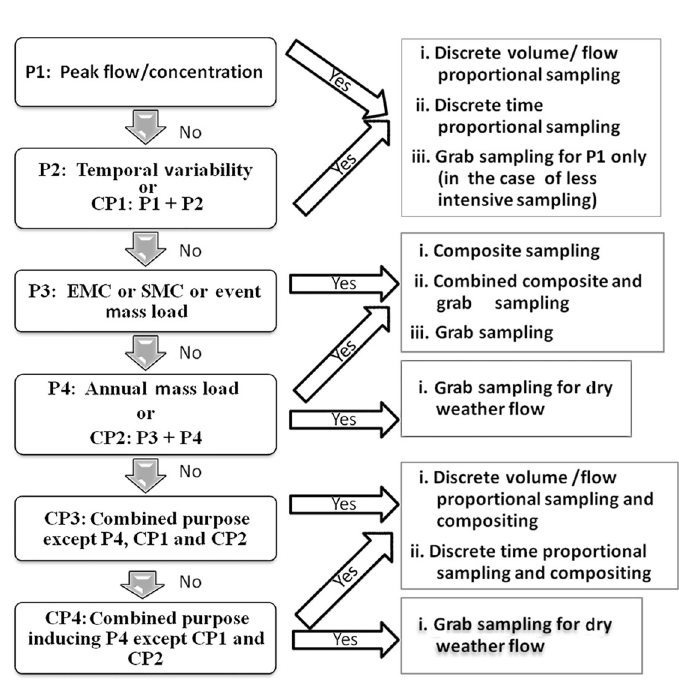
Fig. 1. Sampling method according to different purposes of sampling. P1–P4 are purposes and CP1–CP4 are combined